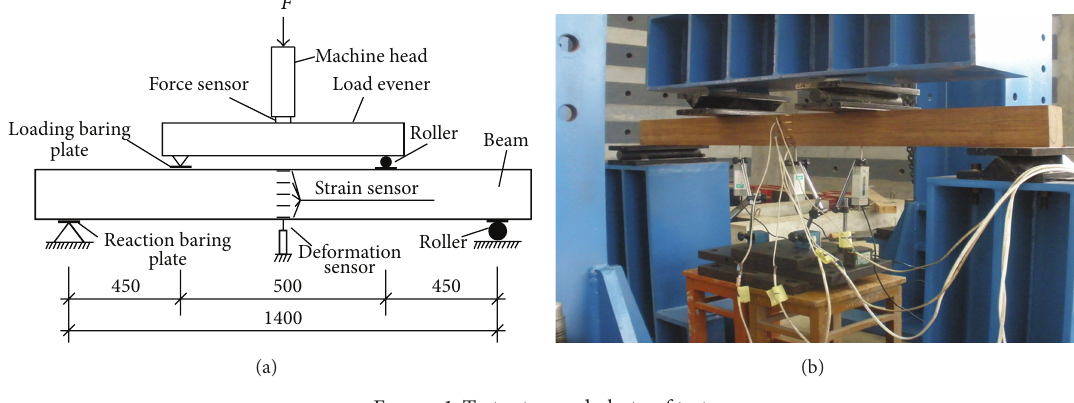
Figure 1: Test setup and photo of